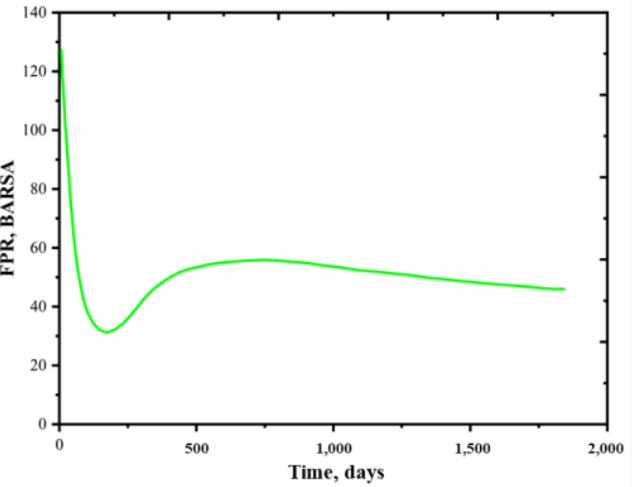
Figure 14. Average pressure for field with horizontal production wells.